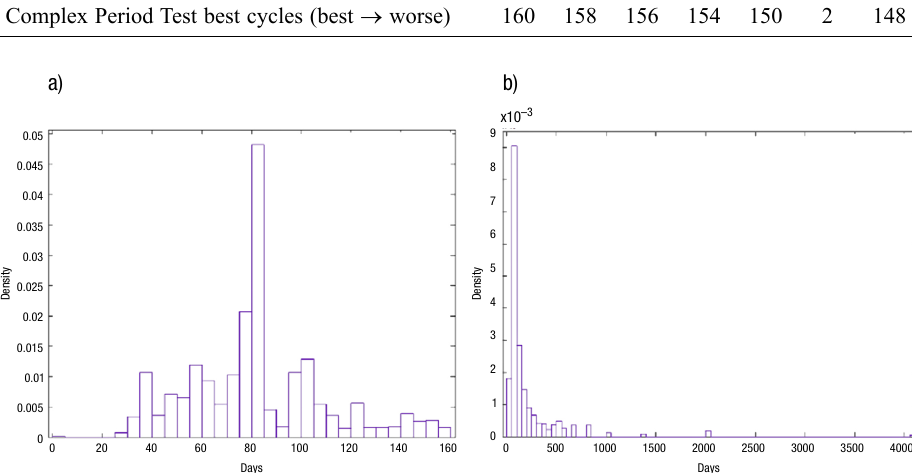
Fig. 6. Histogram of periods resulting from FFT test for periods < 161 days (a), for all periods (b), source: own